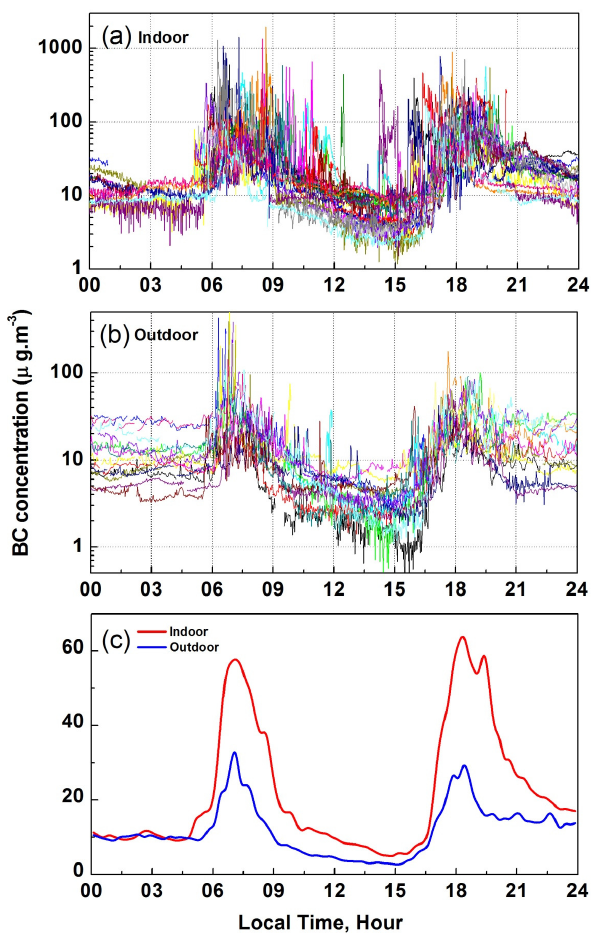
Fig. 3. Daily diurnal variation of BC concentration for the period 6- 26 November 2009 in (a) indoor kitchen of 26 households in Surya village (SVI 1) and (b) at outdoor (ambient) SVI 1 village center (c) Comparison of 15-min median variation of BC concentration in indoor and outdoor for the same period at SVI 1